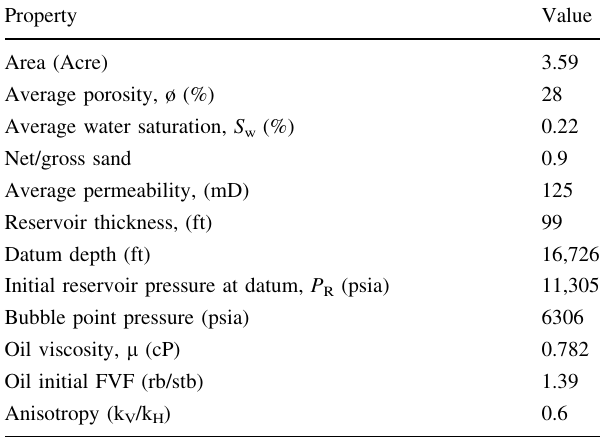
Table 1 Average properties of the reservoir X